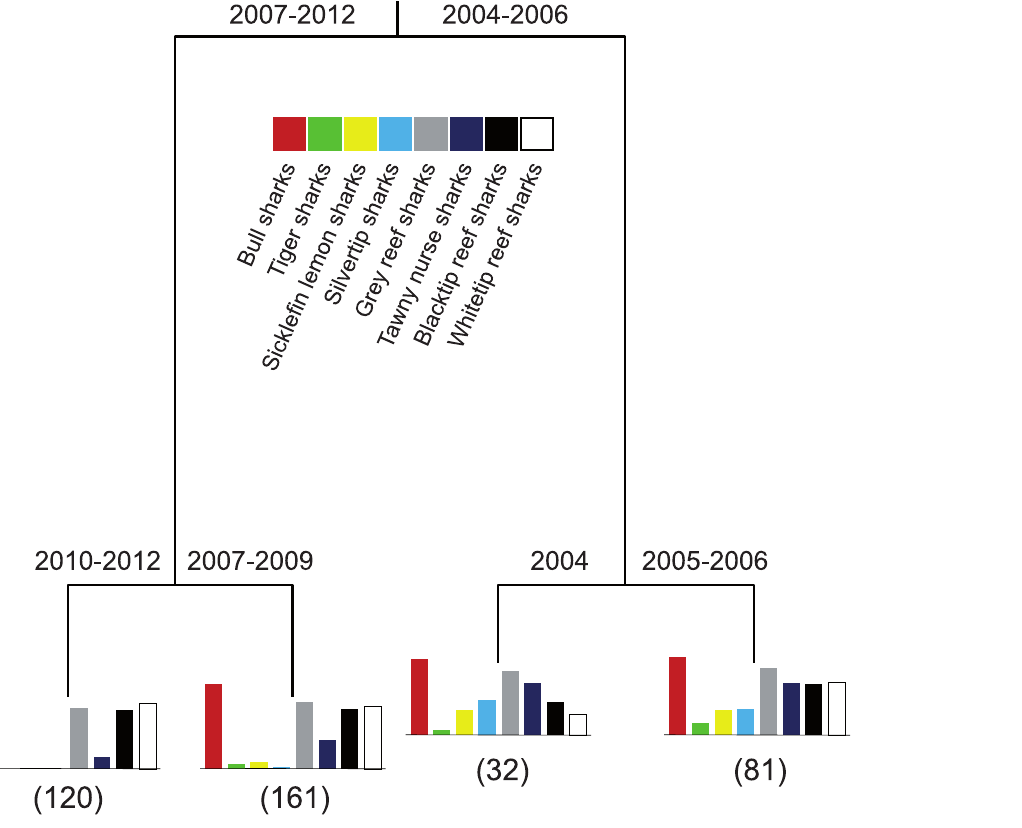
Figure 3. Four-leaf classification and regression tree explaining 32% of the total variability and showing differences in shark community composition between years and months based on relative abundance data from visual surveys. Bar graphs below terminal nodes indicate relative distribution of species abundance (based on fourth-root transformed data on number of sharks detected per 3-day blocks, after the days within each month were placed in a random order). Numbers in brackets are sample sizes. The colour code denotes the colour used in all figures for the respective species throughout this article.